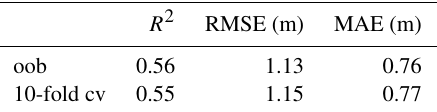
Table 2. Comparison of the RF generalization error quantified by the out-of-bag (oob) procedure and 10-fold cross-validation (cv) based on three metrics, i.e. coefficient of determination ( R 2 ) root- mean-squared error (RMSE) and mean absolute error (MAE). The 1900 additional observations were excluded for this